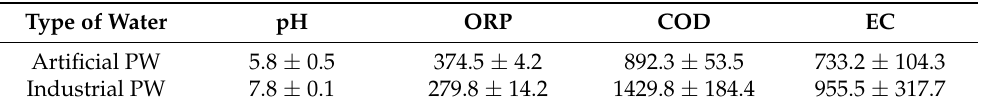
Table 1. Physicochemical characterization of